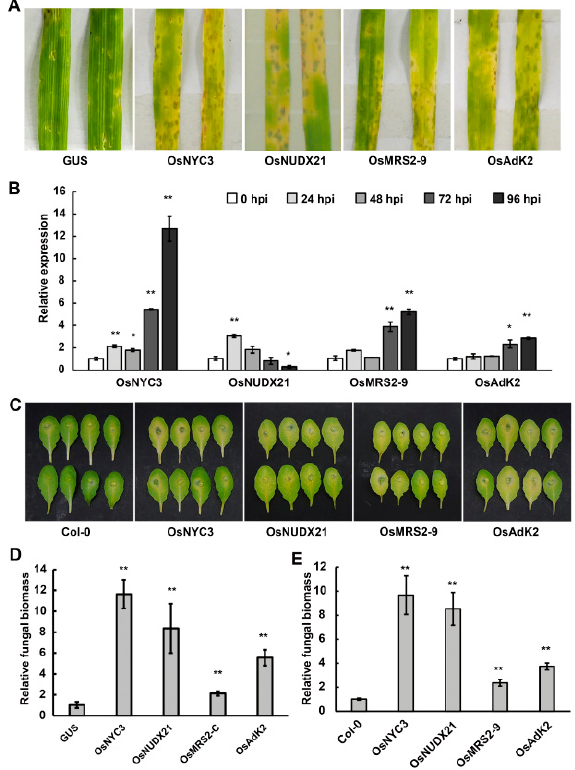
Figure 6. Functional analysis of the chloroplast-related genes OsNYC3 , OsNUDX21 , OsMRS2–9 , and OsAk2 on barley and Arabidopsis . ( A ). Transient expression of candidate genes enhanced blast